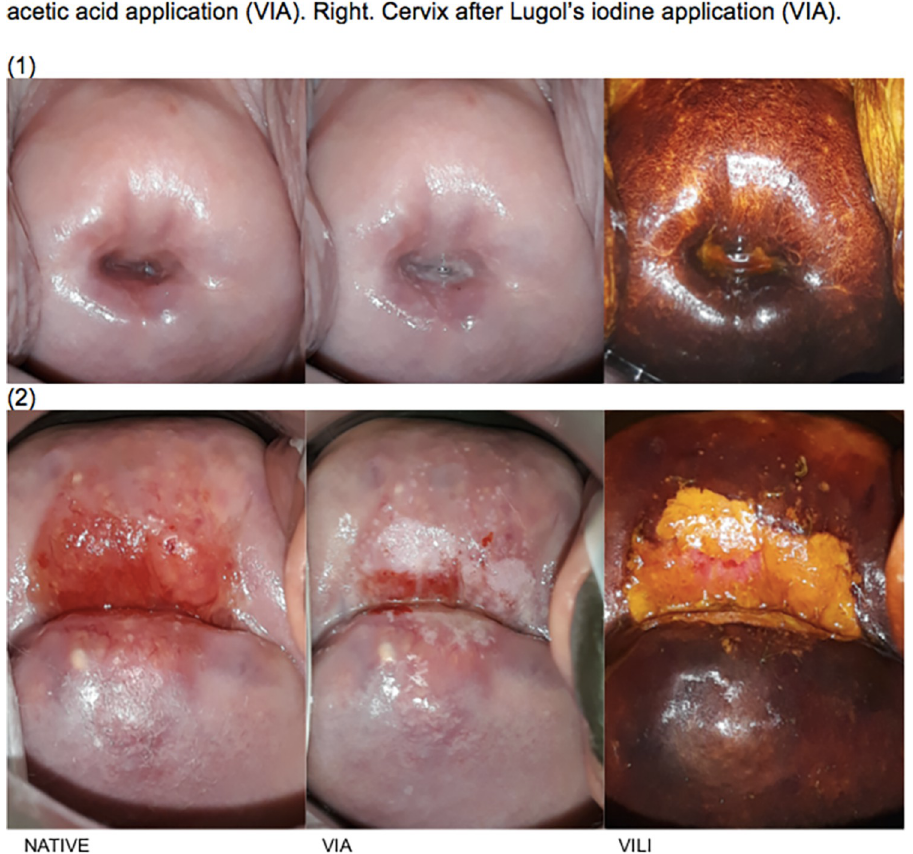
Fig 1. Digital visualization of a healthy (1) and pathological (2) cervix using acetic acid (VIA) and Lugol’s iodine